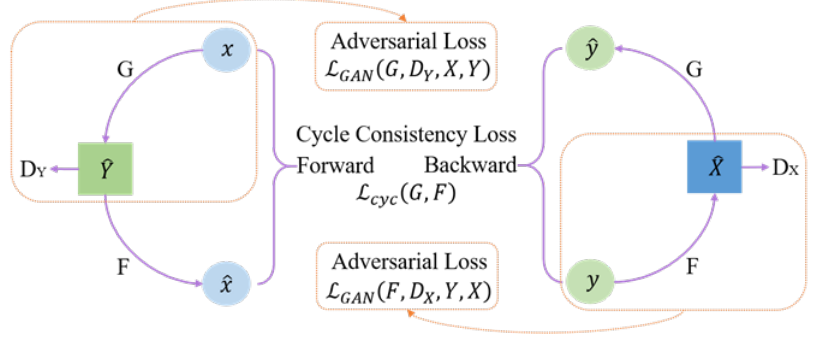
Figure 2. Principle of CycleGAN.